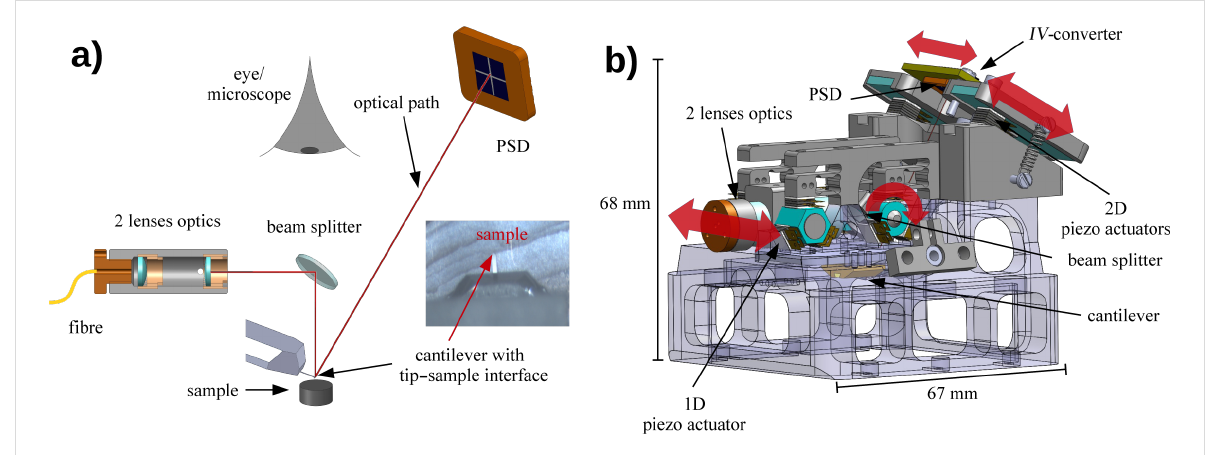
Figure 1: a) Schematic view of the optical path allowing good visibility from the top to the tip–sample setup. The image shows the cantilever above the sample through the beam splitter and an optical microscope. The cantilever is 225 μ m long and 28 μ m wide. b) Beam deflection unit with the key elements focusing optics, beam splitter and PSD with IV -converter. All three elements are adjustable by shear piezo actuators in order to optimally align the light beam. The directions of motion of the mobile parts are shown by the red